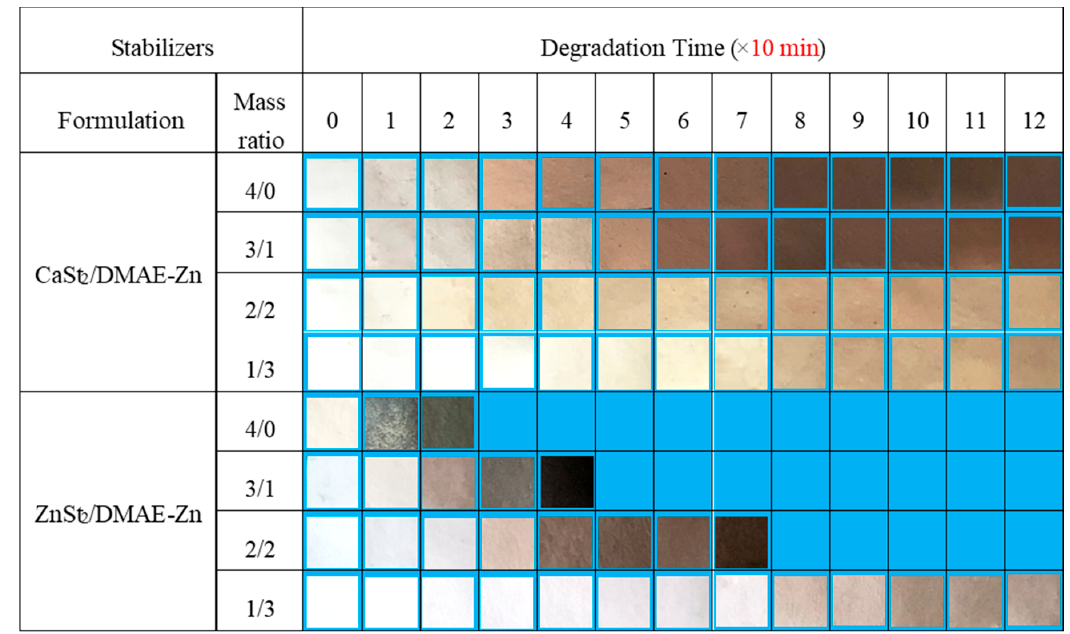
Figure 6. Oven thermal aging test results of PVC stabilized by CaSt 2 /DMAE-Zn and ZnSt 2 /DMAE-Zn.